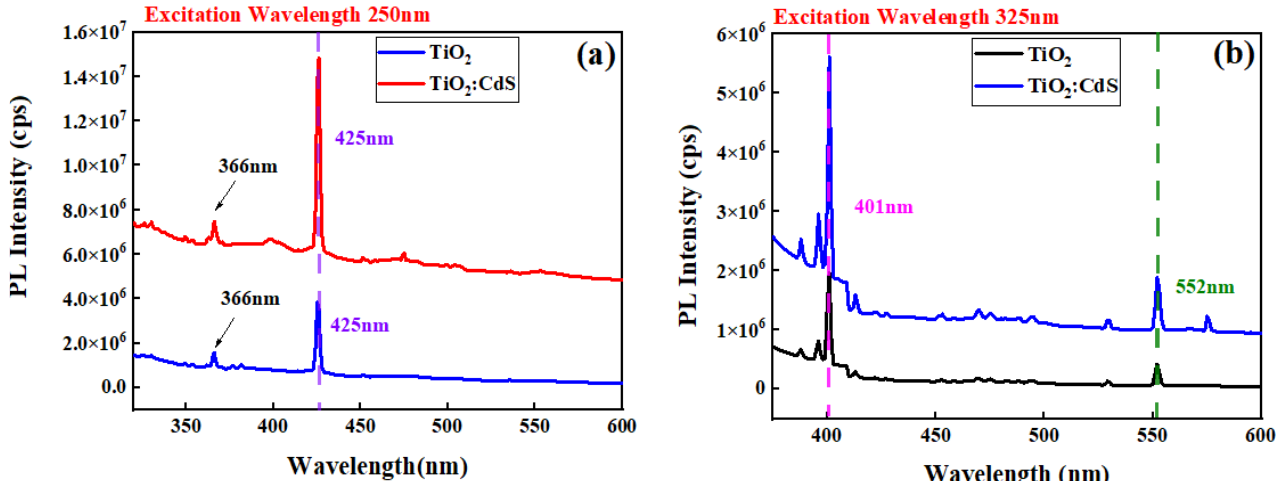
Figure 9. ( a ) PL spectra of TiO 2 and TiO 2 :CdS at 250 nm excitation wavelength; ( b ) PL spectra of TiO 2 and TiO 2 :CdS at 325 nm excitation wavelength.